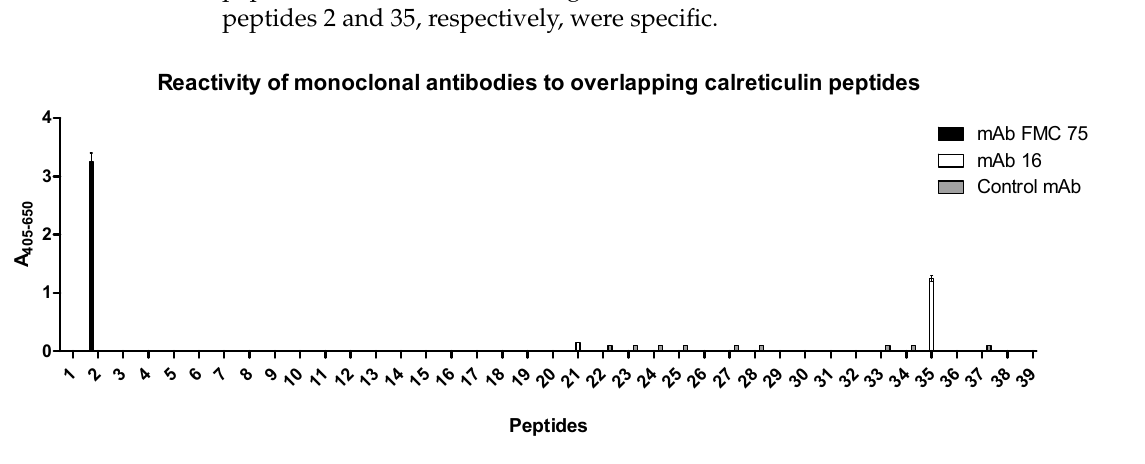
Figure 1. Antibody reactivity to wild-type calreticulin analyzed by enzyme-linked immunosorbent assay. Mouse anti-BAM was used as a negative control. − Ab functions as a control for the secondary antibody goat-anti mouse IgG. − Coat + Ab was added to verify specific reactivity.